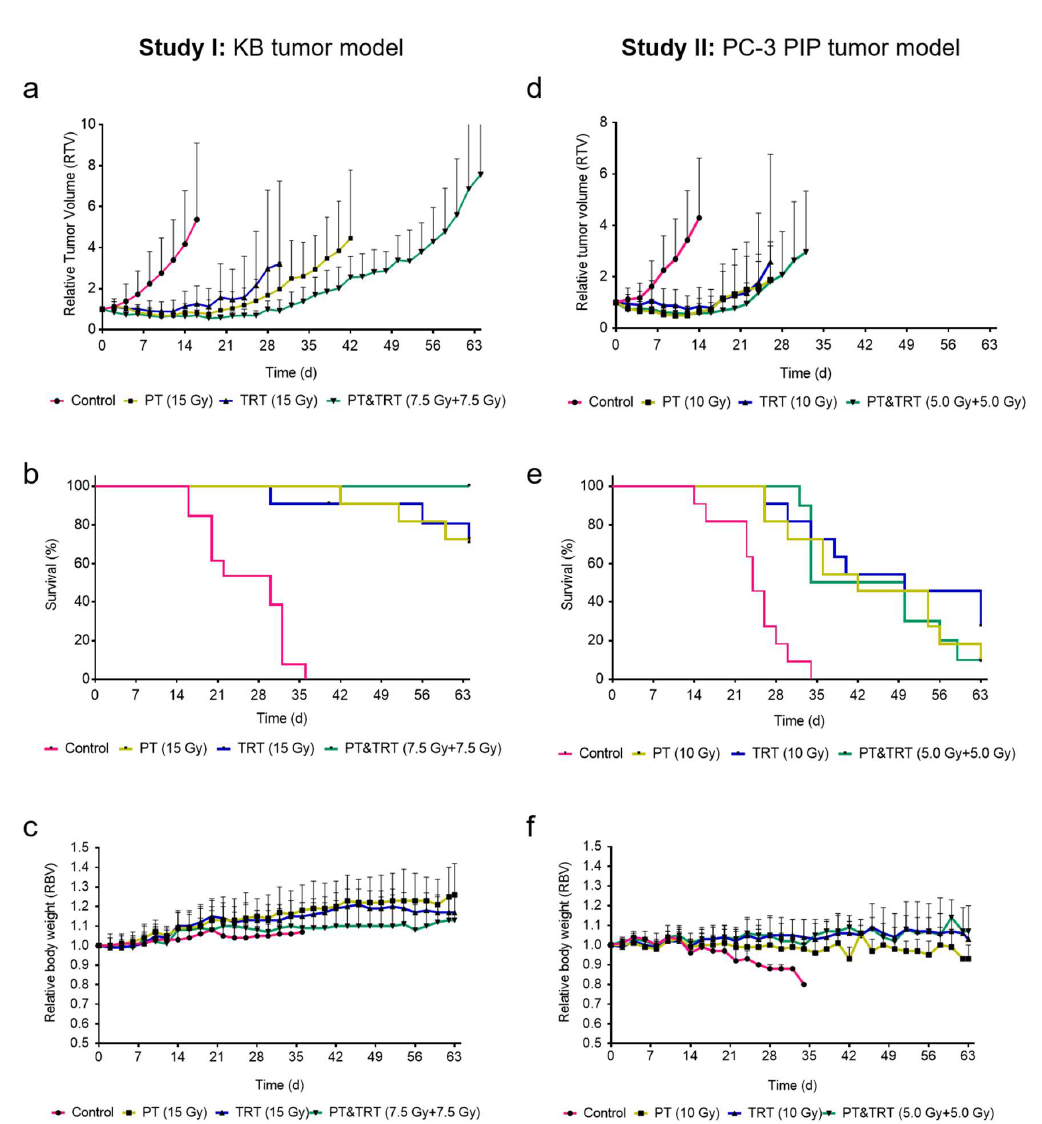
Figure 2. Graphs showing average relative tumor volume of each group until the first mouse of each group had to be euthanized, the median survival and the relative body weight of mice of: Study I ( a – c ); and Study II ( d – f ). Control mice (control; pink), mice treated with protons (PT; yellow), mice treated with 177 Lu-folate (TRT; blue) and the combination of these modalities (PT and TRT; green). ( a , d ) Tumor growth curves shown as average of all mice of one group until the first mouse of each group had to be euthanized; ( b , e ) Kaplan–Meier survival curves; and ( c , f ) relative body weights.